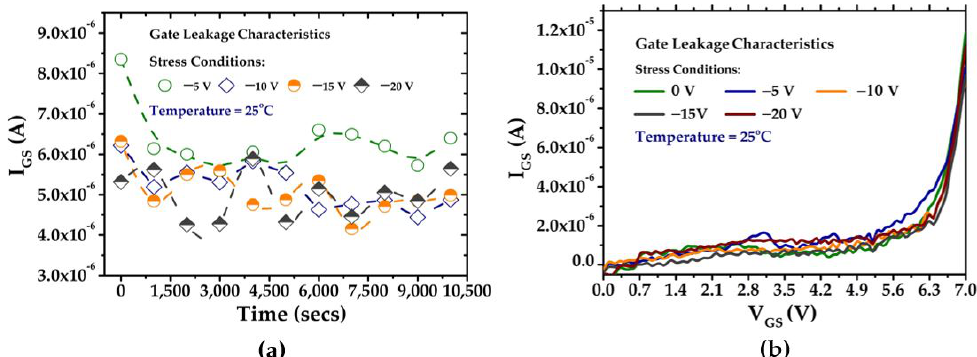
Figure 7. The gate leakage characteristics of p-GaN gate HEMT as a function of ( a ) stress time and ( b ) stress voltages during prolonged negative V GS bias stress.